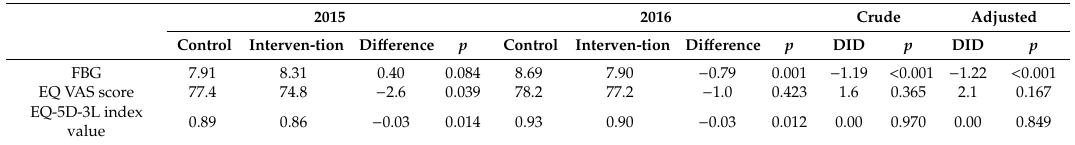
Table 4. FBG level (mmol / L, mean value), prevalence (%) of any problems by EQ-5D-3L dimensions, EQ VAS score (mean), and EQ index value (mean) for the intervention group ( n = 213) and control group ( n = 210) at baseline (2015) and follow-up (2016) stratified by education level and by occupation